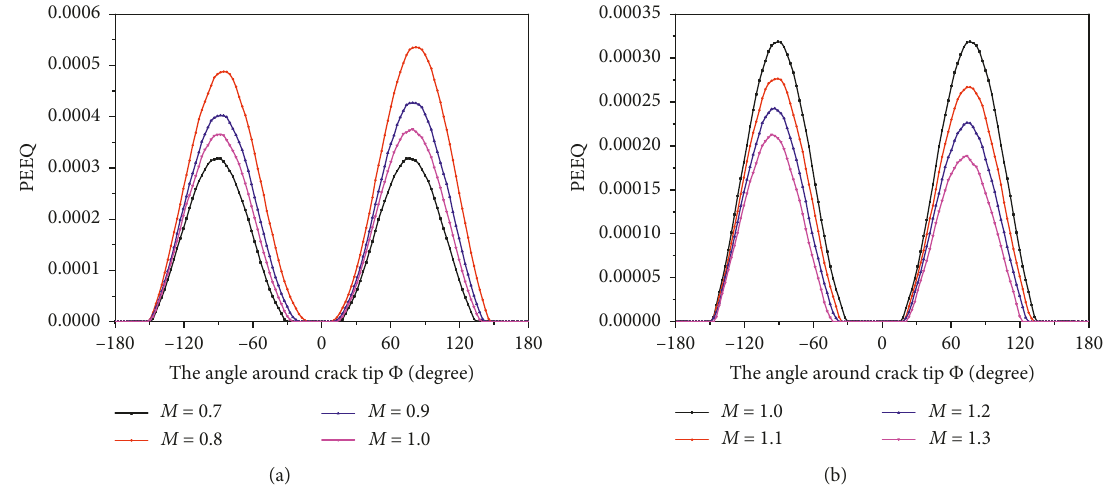
Figure 18: The equivalent plastic strain contour of continuous transition material model around crack tip. (a) Mismatch coefficient M ≤ 1. (b) Mismatch coefficient M ≥